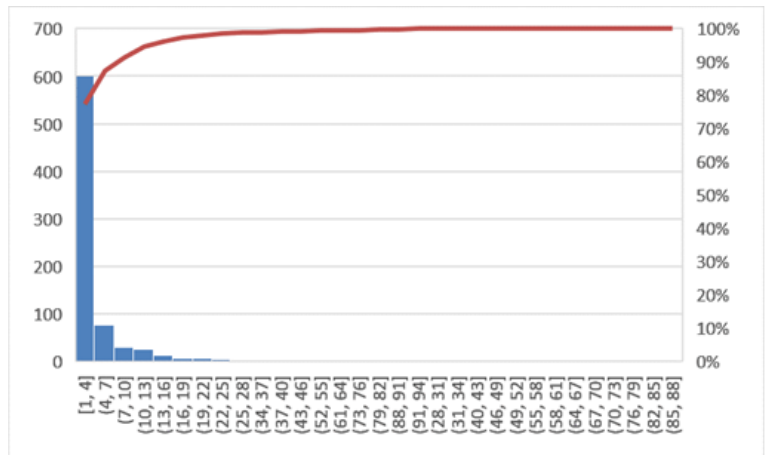
Figure 3. Pareto diagram of number of hospital admissions (2018, 2019).